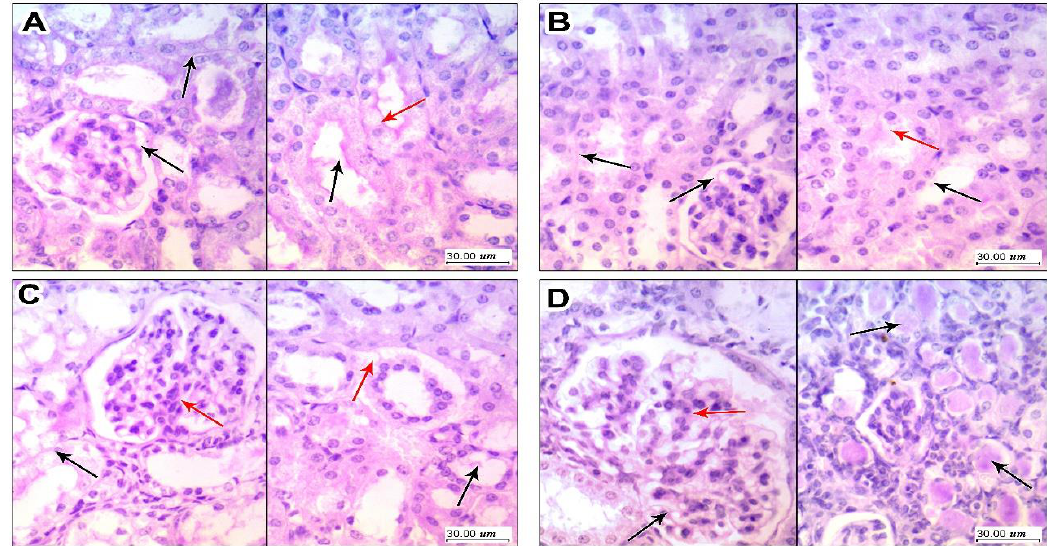
Figure 6. Periodic acid–Schiff staining for the kidney specimen. ( A ) Sections in kidney tissue from vehicle group showing (left panel) glomerulus with thin basement membranes (black arrow) and patent vascular lumen, and tubules showing (right panel) a preserved brush border (black arrow) of tubular epithelial cells with average cytoplasm (red arrow). ( B ) Sections in kidney tissue from the LEFN 2.5 mg/kg group showing (left panel) glomerulus with thin basement membranes (black arrow) and patent vascular lumen, and tubules showing (right panel) a focally disrupted and effaced brush border (black arrow) of tubular epithelial cells and early cytoplasmic vacuoles (red arrow). ( C ) Sections in kidney tissue from the LEFN 5 mg/kg group showing (left panel) glomerular irregularities of vascular lumens with focal increased cellularity (red arrow), but with thin basement membranes (black arrow) (right panel) showing a disrupted and effaced brush border (black arrow) of tubular epithelial cells with moderate cytoplasmic vacuolation (red arrow). ( D ) Sections in kidney tissue from the LEFN 10 mg/kg group showing (left panel) a mild glomerular increase in cellularity (red arrow) with thin basement membranes (black arrow); the right panel shows multiple intratubular eosinophilic hyaline casts filling tubules (black arrow), with marked disruption of lining epithelial cells’ brush borders.